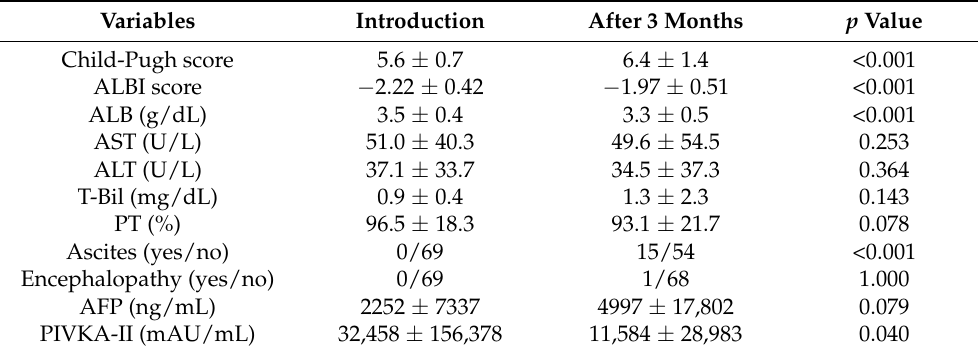
Table 4. Changes in clinical indicators 3 months after the introduction of atezolizumab plus beva- cizumab